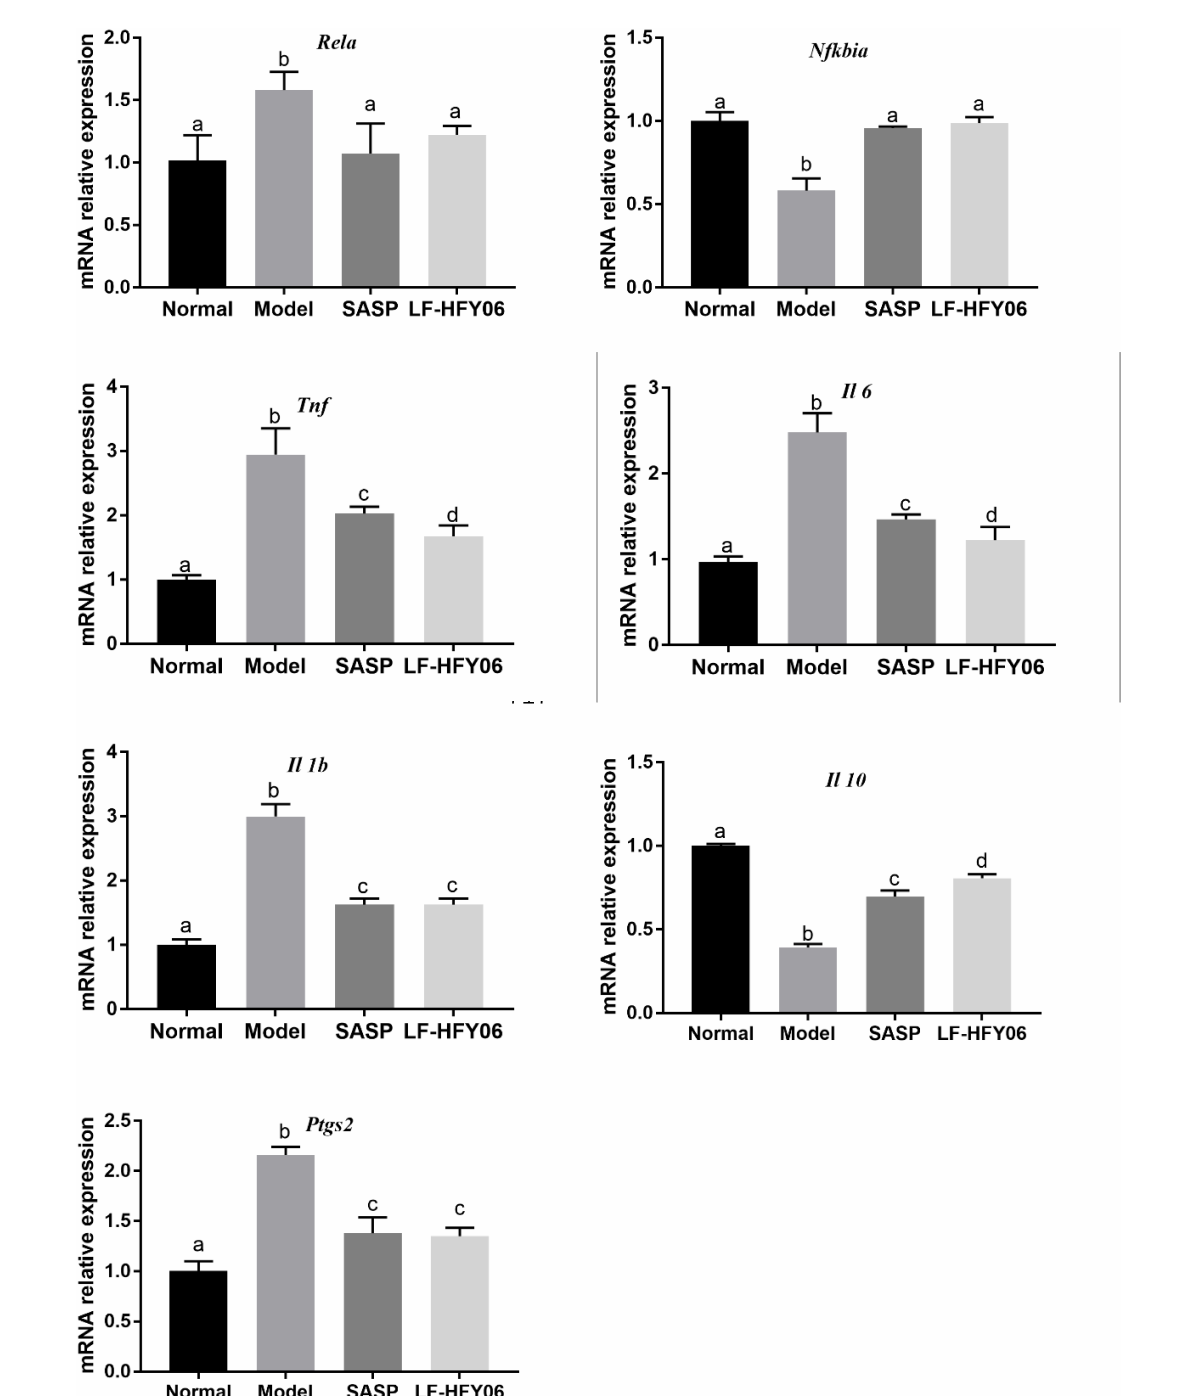
FIGURE4 The Rela, Nfkbia, Tnf, Il 1b, Il 6 , Il 10, and Ptgs2 mRNA expression levels in colon tissues of the different groups. The data are shown as mean ± standard deviation ( n = 8). a - d Significant difference ( P < 0.05) was indicated by different letters after Tukey’s test.